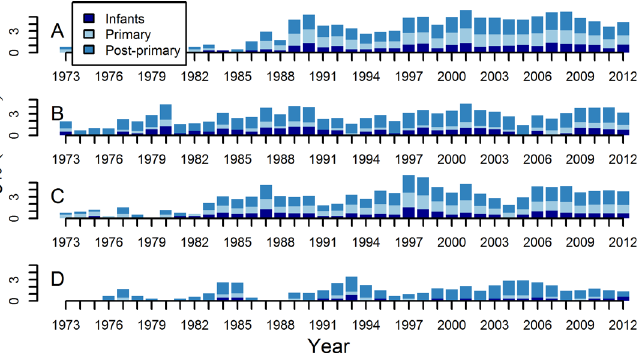
Fig 2. Each figure shows for each serotype individually (A-D: DENV-1 to -4) the number of primary cases in infants, the number of primary cases in non-infants, and the number of post-primary cases each year. Cases are shown on a log 10 scale. Primary cases in infants are in dark blue, post-primary cases are in mid blue, and primary cases in non-infants are in light